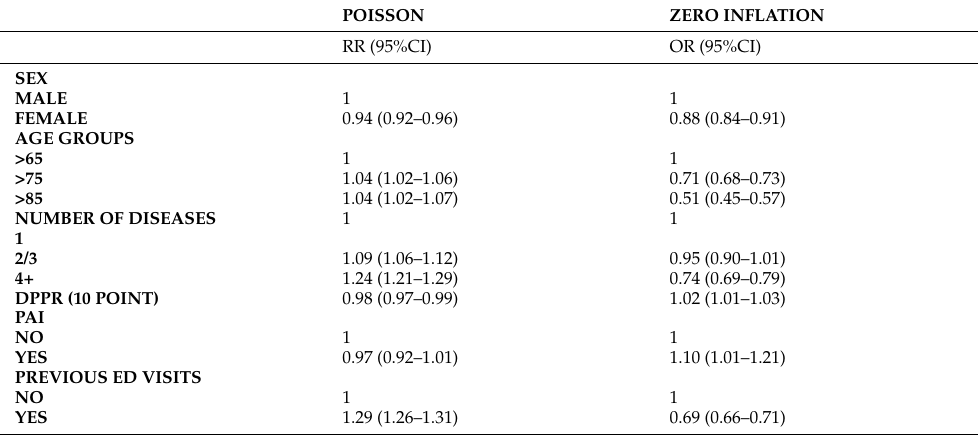
Table 4. Zero-inflated Poisson regression model for factors associated with the number of emer- gency department visits (rate ratios and corresponding 95%CI (Poisson regression); odds ratios and corresponding 95%CI (zero inflation)).